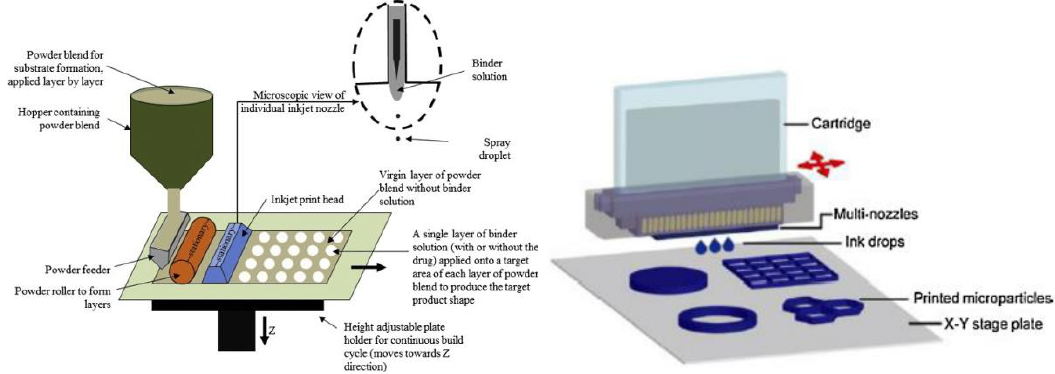
Figure 6. Illustration of drop on solid ( Left ) and drop on drop ( right ) printing process (from Norman et al., [4] and Goole and Amighi, [16], with